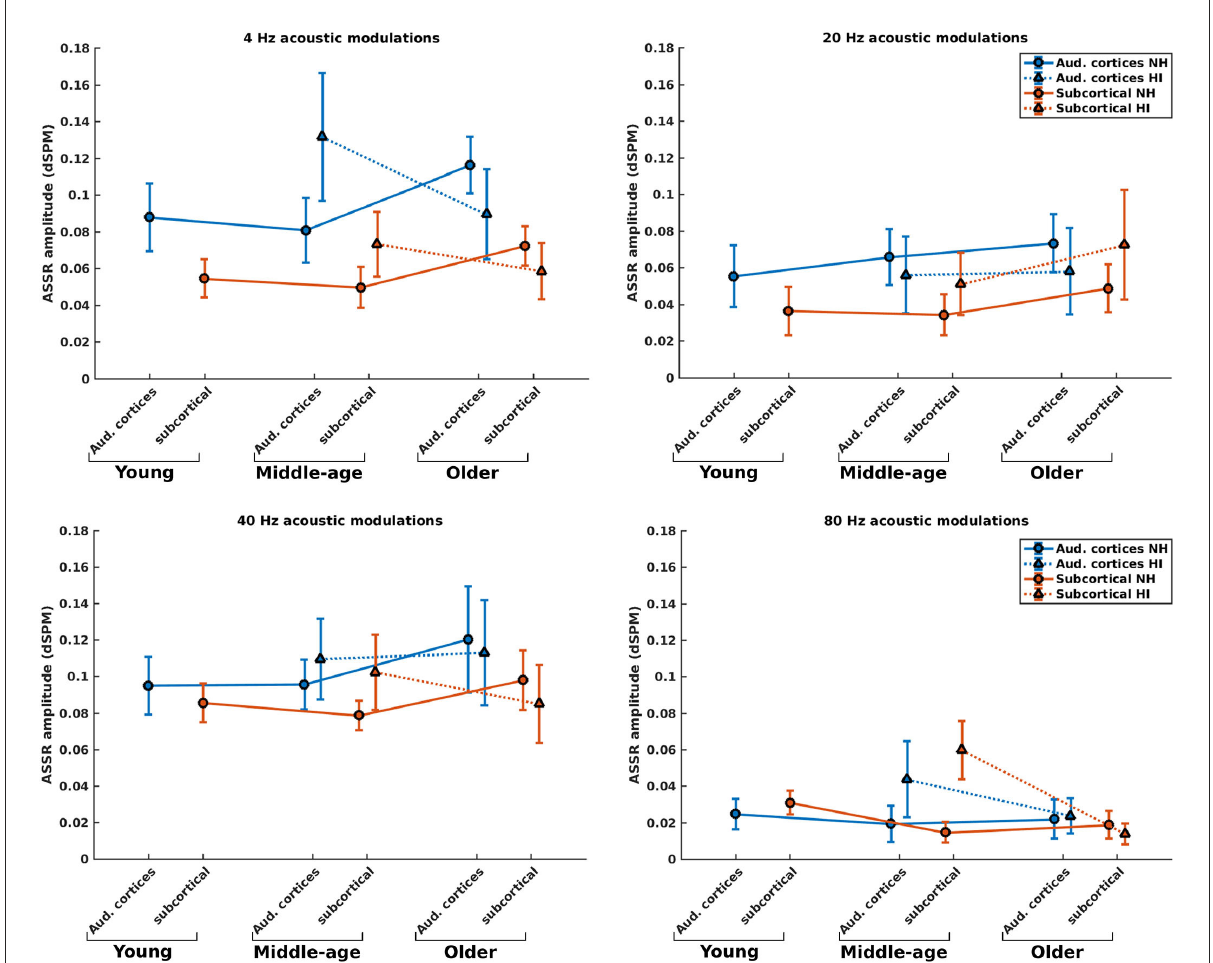
FIGURE3 ASSR amplitudes of the neural generators in the auditory cortices and subcortical neural generators in NH and HI participants regardless of the side of stimulation across age and modulation frequency. The circle and triangle symbols indicate the pooled means (i.e., the weighted average of amplitudes across the side of stimulation and the side of generators; number of subjects as weights), and error bars represent the pooled standard deviations